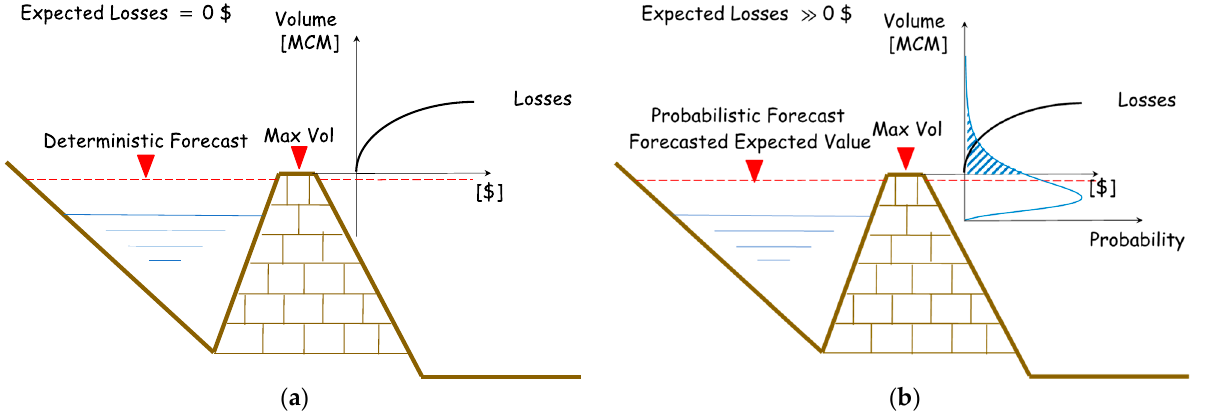
Figure 3. Comparison between the expected losses estimated ( a ) deterministically, according to the expected value of the volume forecast, and ( b ) probabilistically, by integrating the product between losses and their predictive probability of occurrence.